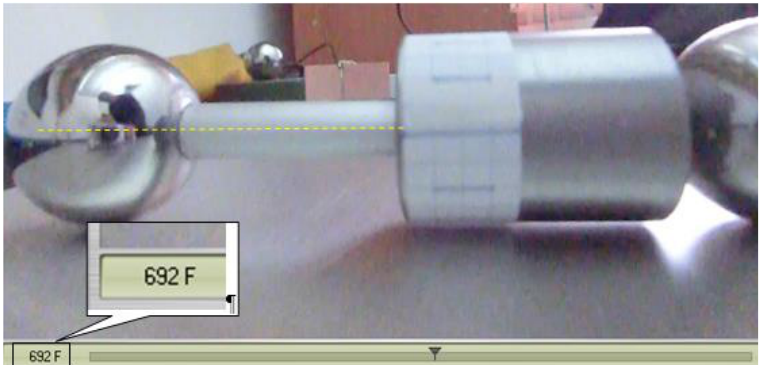
Figure 19. Identification of movie frame index for the rolling rotor.